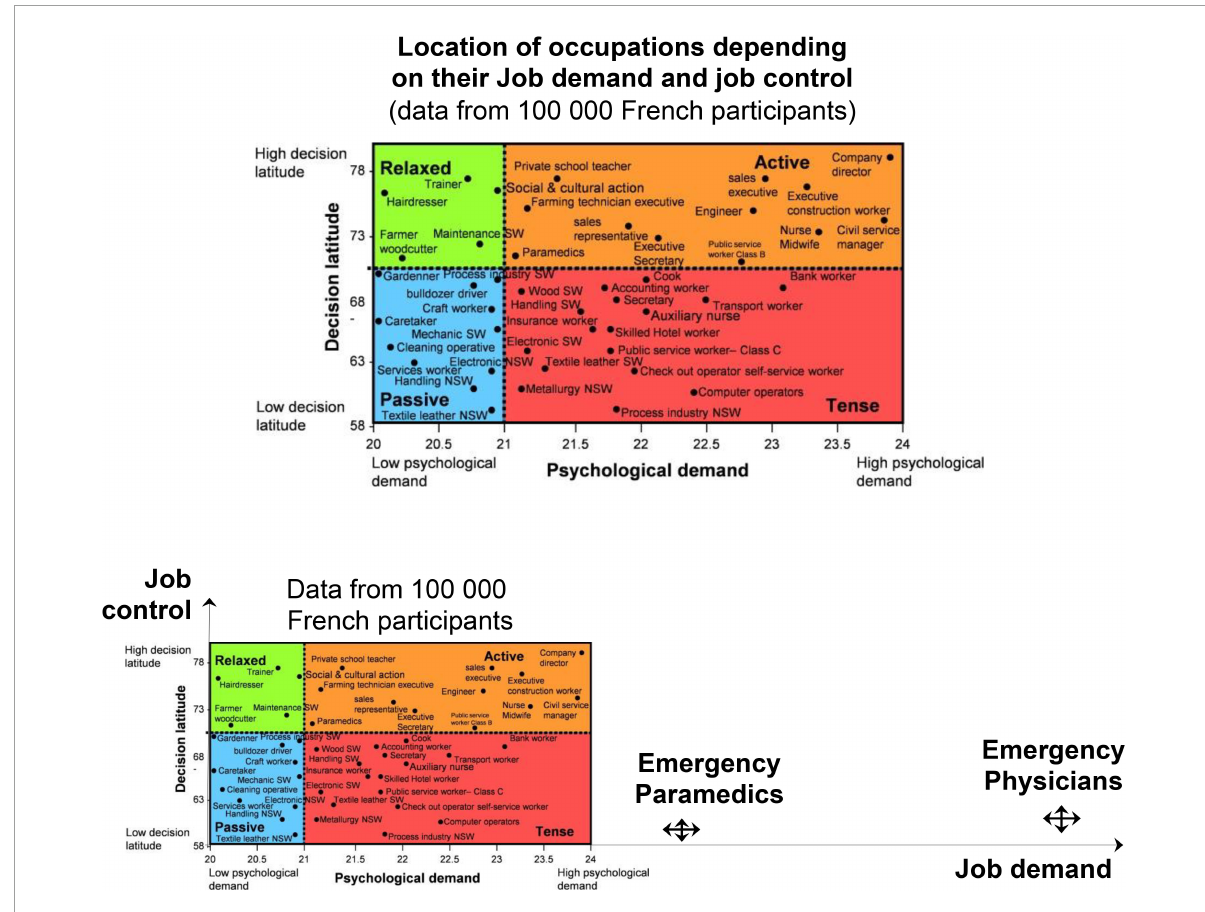
FIGURE4 Representation of emergency physicians and paramedics compared to other jobs. Results of other jobs are from the study of the validity of a job-exposure matrix for psychosocial work factors: results from the national French SUMER survey. Int Arch Occup Environ Health 82: 87–97; 15